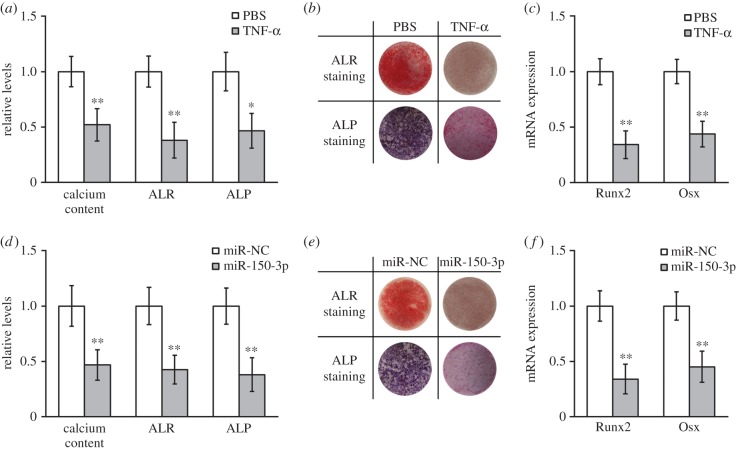
TNF-α treatment and miR-150-3p transfection both inhibited osteogenic differentiation of hBM-MSCs. (a) Calcium content, alizarin red (ALR) and alkaline phosphatase (ALP) staining assays were measured in hBM-MSCs treated with either PBS (as control) or TNF-α. (b,c) Representative images of ALR and ALP stainings (b), and expressions of Runx2 and Osx (c) after the same treatment as in (a). (d) Calcium content, alizarin red (ALR) and alkaline phosphatase (ALP) staining assays were measured in hBM-MSCs transfected with either miR-NC (negative control) or miR-150-3p. (e,f) Representative images of ALR and ALP stainings (e), and expressions of Runx2 and Osx (f) after the same treatment as in (d). Data presented as mean ± s.d. from at least three independent experiments. **p < 0.01, *p < 0.05 compared with respective PBS or miR-NC control.